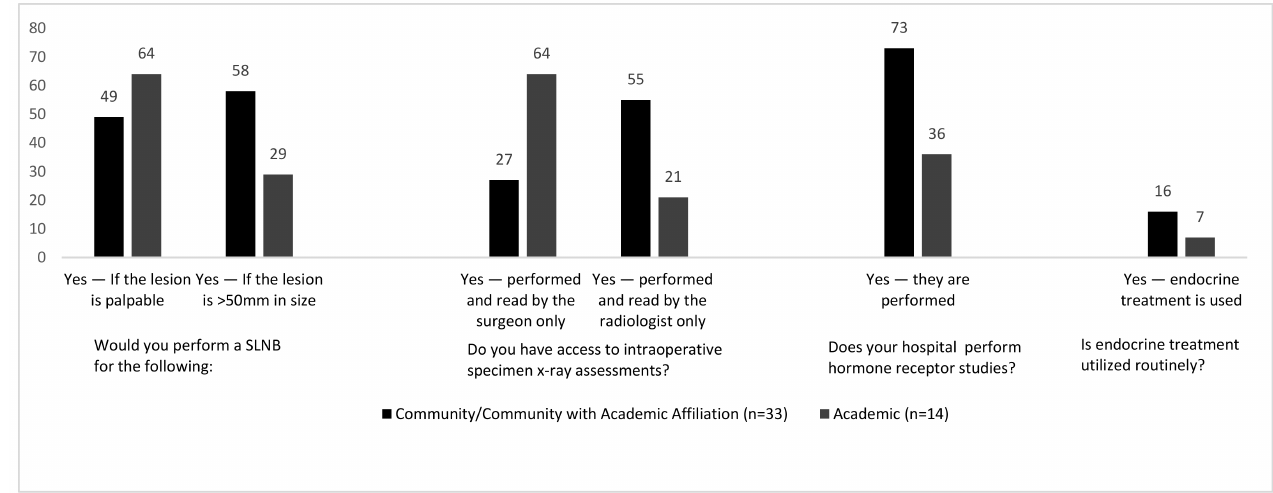
Figure 2. % of participants responding to various questions broken down by site of practice: Community vs.